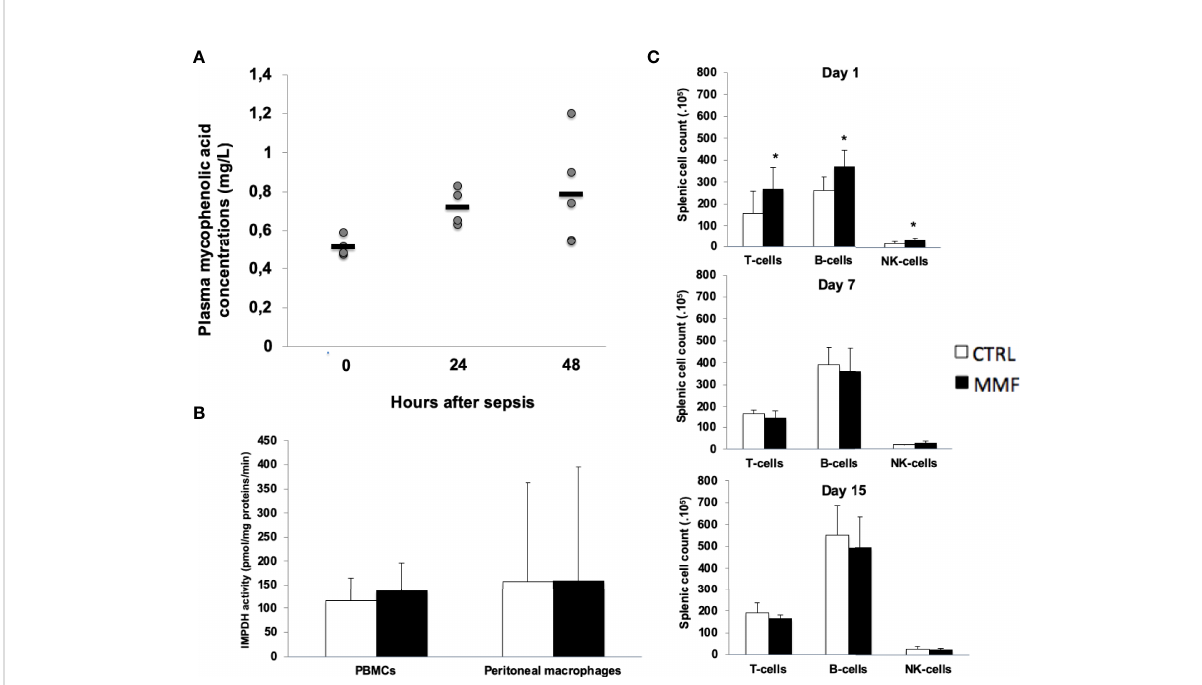
FIGURE 1 Low-dose MMF did not have any impact on splenic lymphocytes sub-population and IMDH activity during sepsis Mice received MMF i.p. 20 mg/ kg once daily, one day before i.p. injection of 10 8 S. aureus and for 4 more days. Trough concentrations were measured at H0 (n=4), H12 (n=4) and H24 (n=5) (A) . IMPDH activity was measured in PBMCs and in peritoneal macrophages 4 days after treatment with MMF (or vehicle), one hour after the last injection (B) . Splenic lymphocyte sub-populations were counted by fl ow cytometry, at day 1, 7 and 15 of sepsis (C)